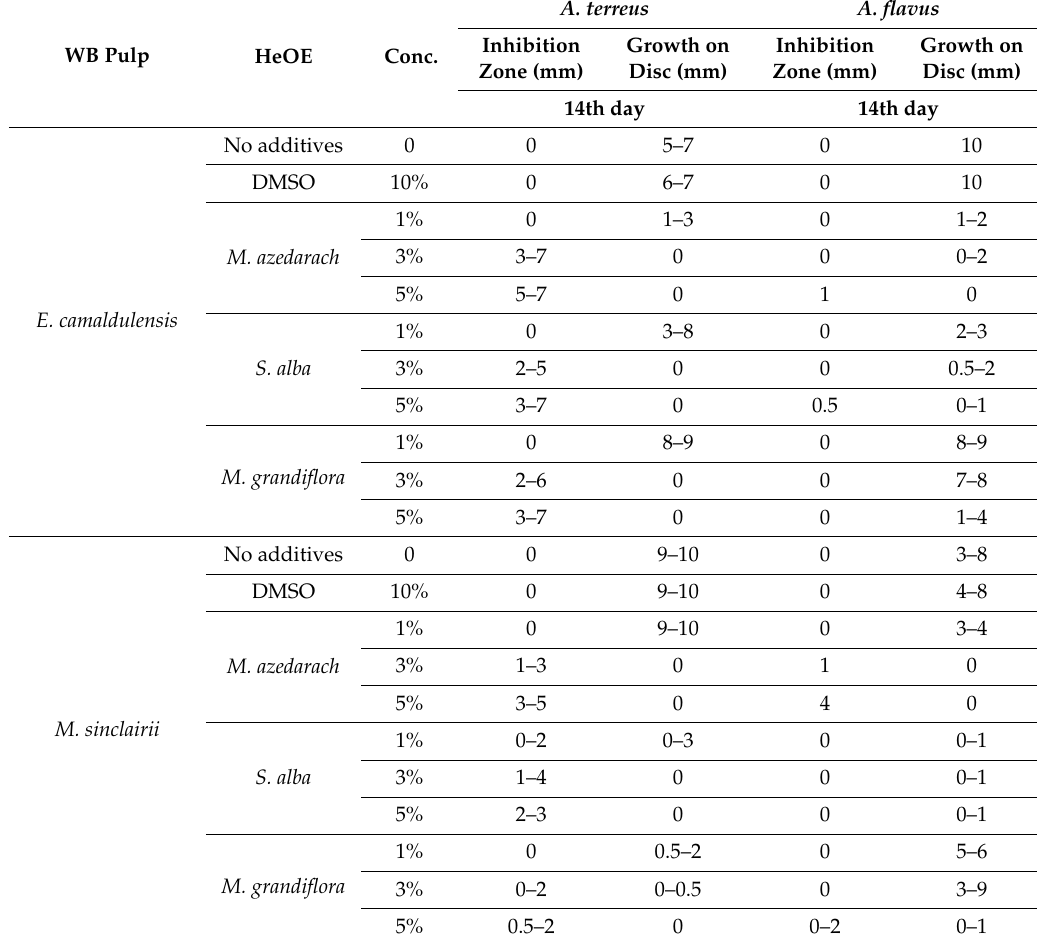
Table 6. Screening of antifungal activity of produced paper sheets against growth of A. terreus and A.